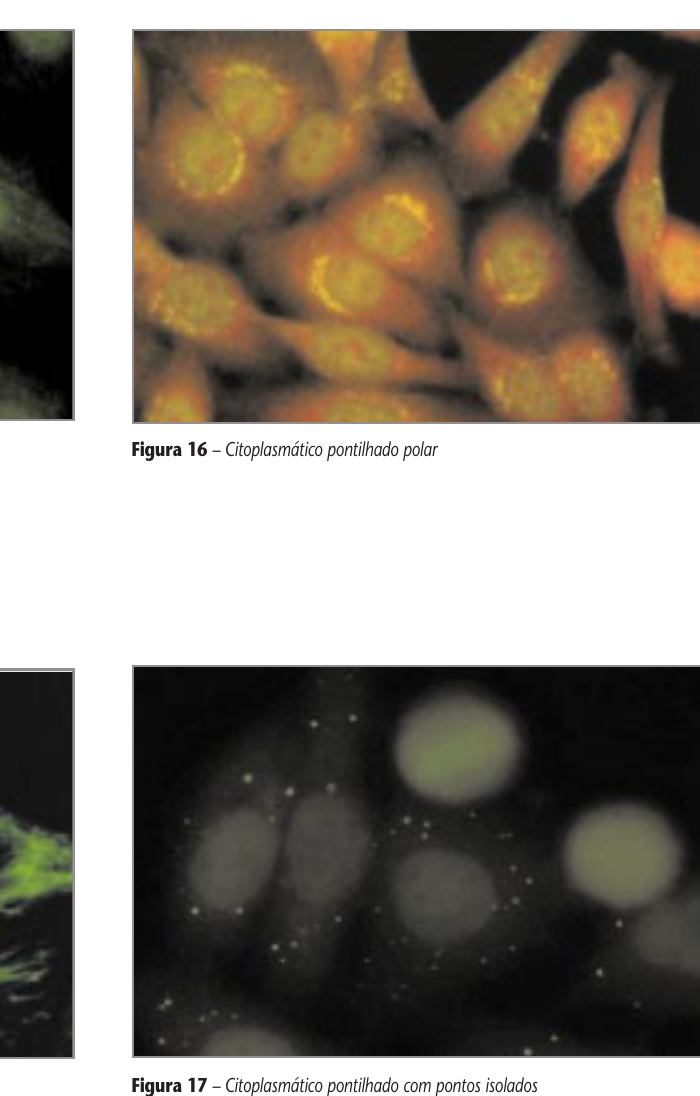
Figura 14 – Citoplasmático fibrilar filamentar